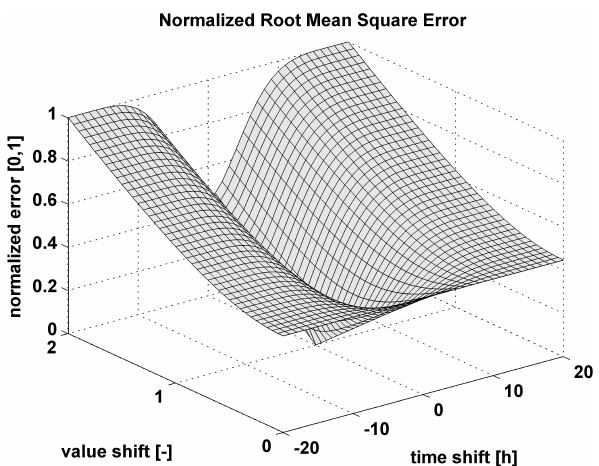
Fig. 2. Error surface of the Root Mean Square Error (RMSE) for synthetic, triangular events as shown in Fig. 1. Simulations are shifted in time (offset range [ − 20h, 20h]) and amplitude (multi- plier range [0, 2]). The error surface is normalized to [0, 1] by means of division with the maximum